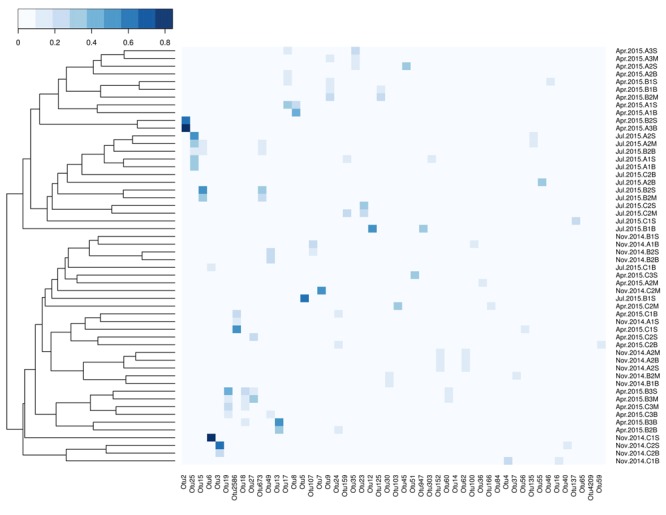
Heatmap of the top 50 OTUs based on their relative abundance across samples from Qinhuangdao coastal area. Sample relationships are shown through clustering based on Bray–Curtis dissimilarity measure. Of these OTUs, the classified OTUs belonged to phyla Ascomycota (OTU# 3, 4, 7, 14, 16, 40, 73), Basidiomycota (OTU# 6, 36, 37, 65), and Chytridiomycota (OTU# 59). The color-key indicate the range of relative abundance of the OTUs.